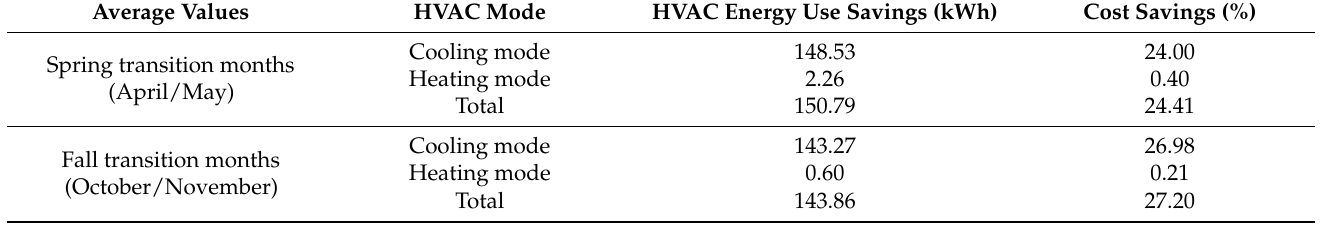
Table 4. HVAC energy use evaluation in a typical household.